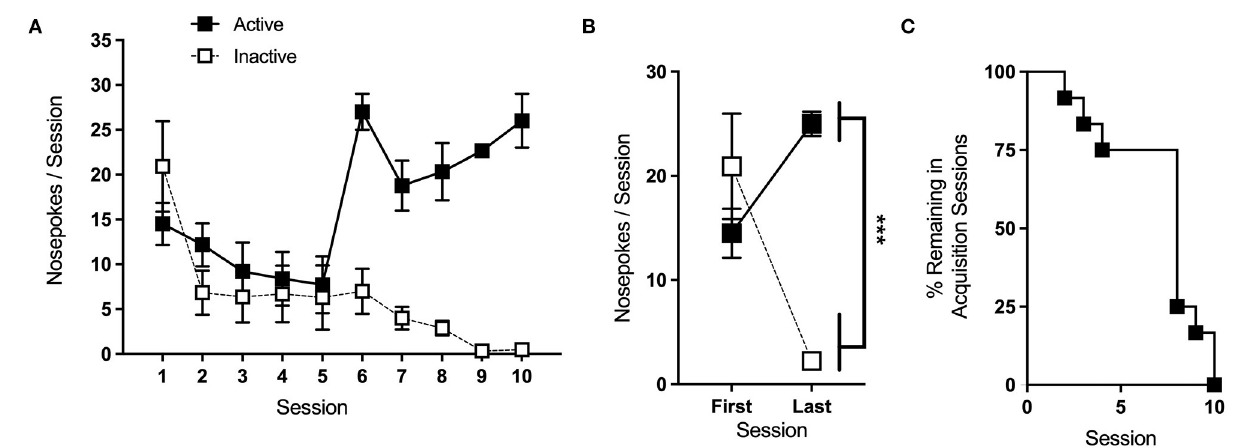
FIGURE 6 | Acquisition. (A) Average nose-pokes (active port, large boxes; inactive port, and small boxes), excluding responses made during time-out periods, during acquisition sessions for which > 25% of animals remained. (B) Mice made significantly more nose-pokes at the active port than the inactive port during the last acquisition session. (C) The rate at which animals met the criteria and progressed to the next phase of testing. *** p < 0.001; n/group = 12; data shown are mean ± S.E.M. Modified from Huebschman et al., 2021, with permission from Wiley and the Federation of European Neuroscience Societies. The figures include data collected with support from the NIDA Drug Supply Program (gifted drug) and Texas A&M University (LS).